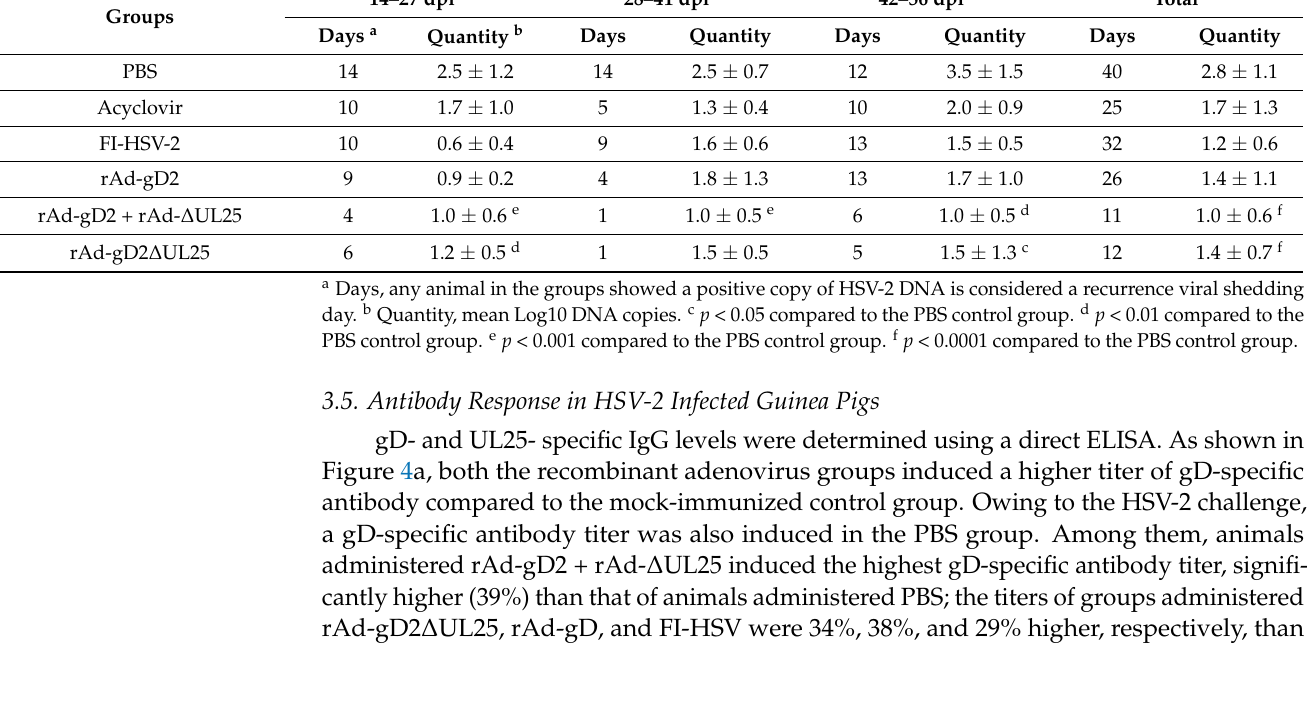
Table 3. Effect of adenovirus vaccines on viral shedding in HSV-2-infected guinea pigs. Recurrent Viral